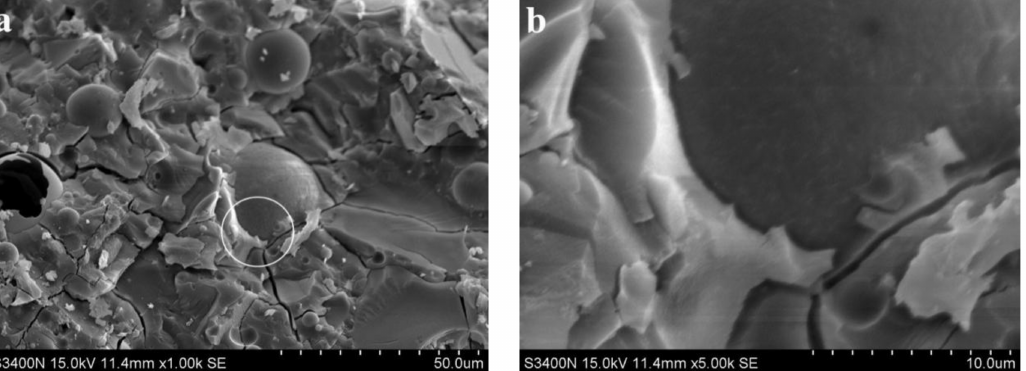
Figure 6. SEM images of the alkali slag cement slurry with 50% fly ash at hydration age of 3 d. ( a ) × 1.00 k, ( b ) × 5.00